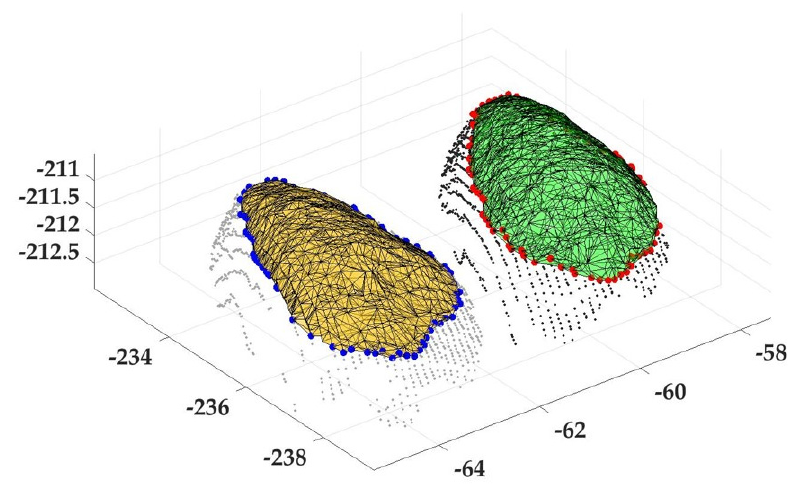
Figure 7. Complete single − grain classification results. The blue dot represents the nearest polyhedron on the left and the red dot represents on the right.